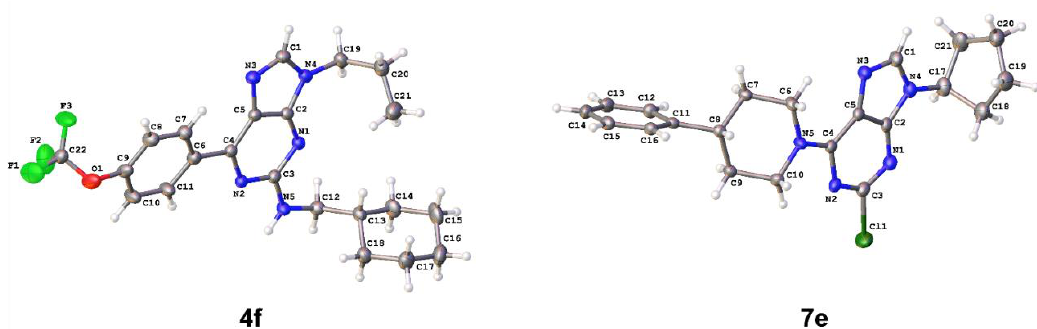
Figure 3. Molecular structure of selected purines 4f and 7e obtained by X-Ray diffraction analyses. Thermal ellipsoids are shown with 30% probability.